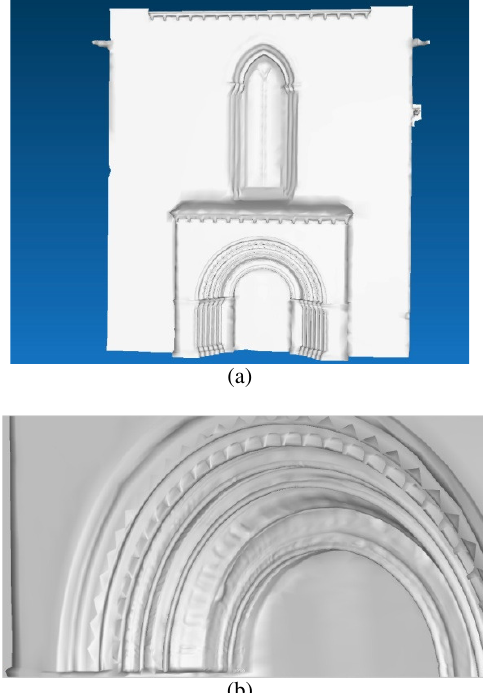
Figure 9: Constrained mesh: (a) General view; (b) Close-up